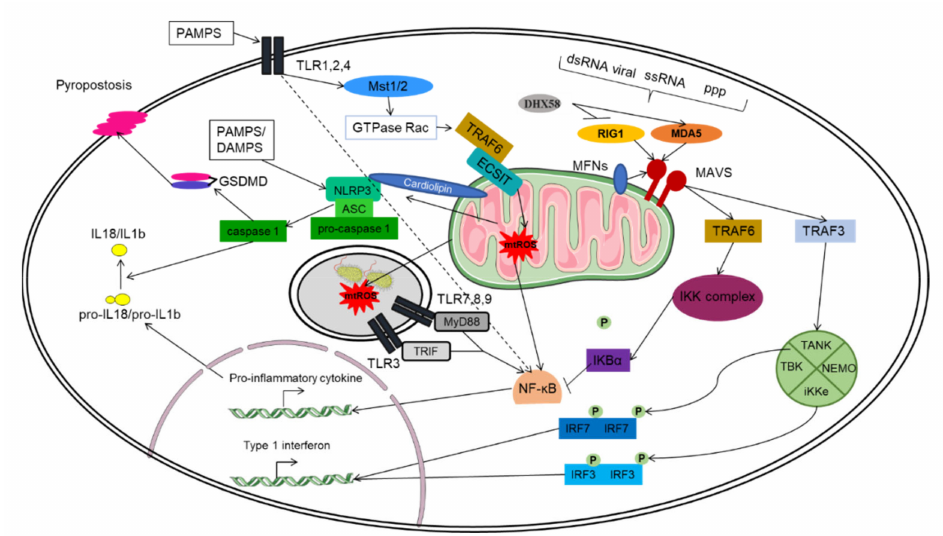
Figure 5. The mitochondria at the center of the RLR, NLR and TLR pathways. The mitochondrion plays an important role in the innate immune response, as it participates in the main pathways involved in the immune response: the TLR, RLR and NLR pathways. The TLR pathway is involved in the antimicrobial response. PAMPs will activate the TLRs. The membrane-spanning TLRs (TLR1, TLR2, TLR4) and endosome-bonded TLRs (TLR3, TLR7, TLR8 and TLR9) are activated and trigger the expression of pro-inflammatory cytokines via the NF-kB pathway. The TLRs activate the kinases Mst1 and Mst2, which activate the GTPase Rac allowing the assembly of the TRAF6-ECSIT complex. The TRAF6 translocates to the mitochondria and binds to ECSIT, forming the TRAF6-ECSIT complex, which lead to an increase in mitochondrial ROS (mtROS) production as well as the proximity of the mitochondria and the phagosome. The bacteria in the phagosome will be destroyed by the action of mtROS. The RLR pathway is involved in antiviral response. Different PAMPs such as dsRNA, ssRNA and 5 (cid:48) -triphosphate (ppp) will activate two cytoplasmic PRRs, RIG-1 and MDA5. These PRR are regulated by DHX58, where DHX58 positively regulates MDA5 and negatively regulates RIG-1. After the interaction with DHX58/RIG1/MDA5, MAVS is activated by recruiting different proteins, such as TRAF3 and TRAF6. The interaction between MAVS and the MFN1 and MFN2 fusion proteins (MFNs) are essential for RLR pathway signaling. TRAF3 will activate the TANK/NEMO/iKKe/TBK complex, which will phosphorylate IRF7 and IRF3 dimers, allowing their translocation into the nucleus and their binding to ISRE sequences at the promoters of type I IFN-regulated genes, while TRAF6 will activate the IKK complex. This complex activates NF-kB by phosphorylating its inhibitor IKB α . Once activated, NF-kB translocates to the nucleus to induce the expression of pro-inflammatory genes. The NLR pathway is involved in a mechanism for fighting infection and cellular damage. The main complex of this pathway is the NLRP3 inflammasome. The inflammasome is a multiprotein complex containing ASC, pro-caspase 1 and NLRP3. The activation of NLRP3 inflammasome is done both on transcriptional and post translational levels. The first is related to TLR activation and production of pro-IL1b and pro-IL18. The second signal is based on the detection of PAMPs and DAMPs that leads to NLRP3 oligomerization and interaction with ASC. Then, ASC recruits pro-caspase 1 via the CARD domain. Once caspase 1 is activated, it cleaves the pro-IL1b and pro-IL18 which will allow the release of these inflammatory cytokines in the extracellular milieu. In addition, caspase 1 cleaves Gsdmd, which will allow pore creation at the plasma membrane and pyroptosis. In addition, MAVS is also necessary for the recruitment of NLRP3 in mitochondrial membranes. Cardiolipin and mtROS promote the activation of NLRP3 inflammasome. There are four families of PRRs, toll-like receptors TLRs [58], (NOD)-like receptors (NLRs), C-type lectin receptors (CLRs) and retinoic acid-inducible gene I (RIG-I)-like receptors (RLRs). Each PRR allows the secretion of type I interferon and pro-inflammatory cytokines via NF-kB